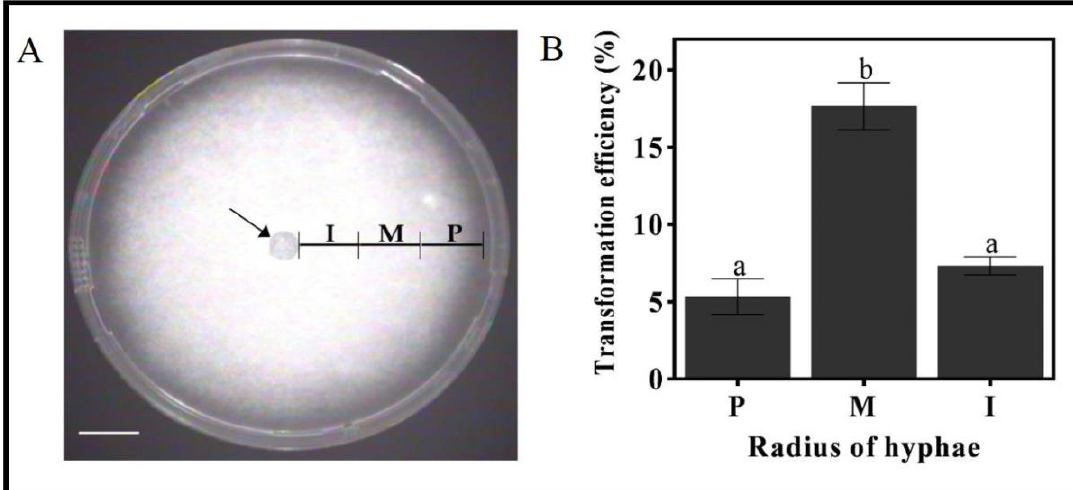
Figure 4. The e ff ect of mycelia developmental stage on the T. boudieri transformation e ffi ciency. ( A ) Mycelia cylinders were excised along the radius of growth. I, Interior 1–1.5 cm from the origin of growth; M, Middle 1.5–3 cm; P, Peripheral 3–4.5 cm. The plates were grown for 3 weeks on Fontana medium prior to the cylinders’ excision. Bar = 1.5 cm. ( B ) Transformation e ffi ciency of mycelia